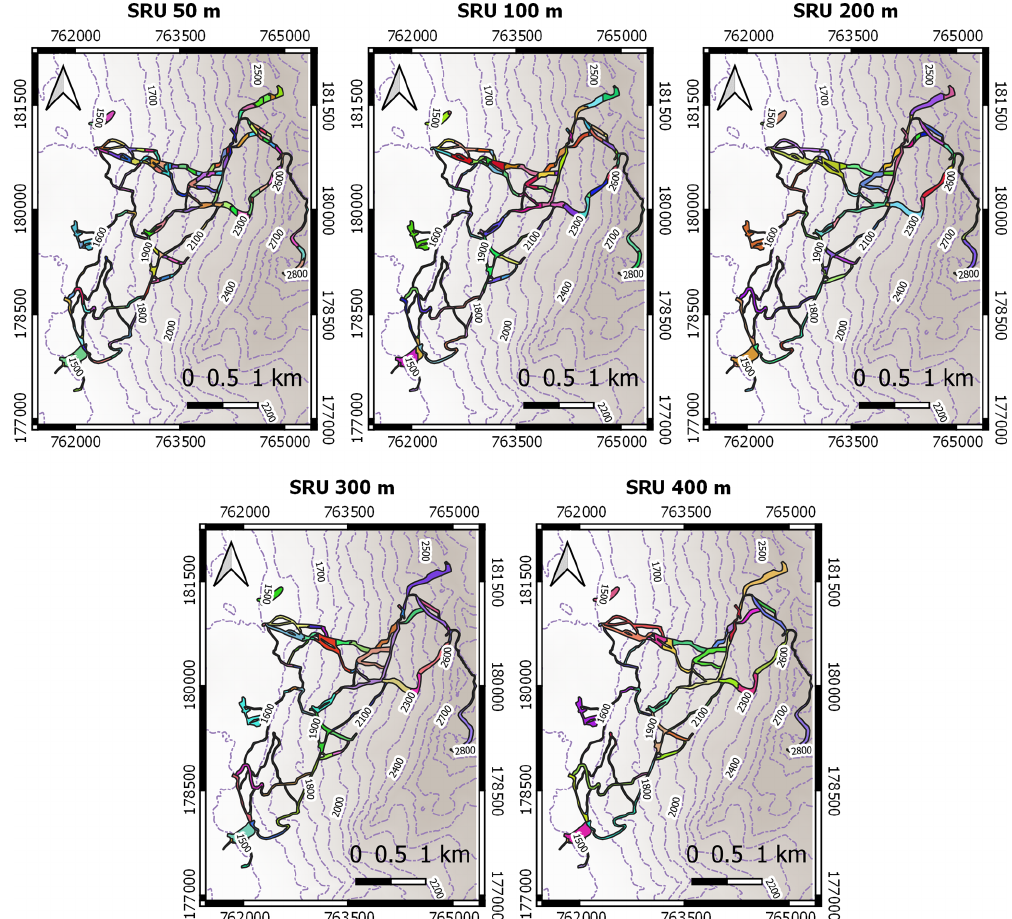
Figure 2. An example of a ski resort discretization into different SRU elevation bands: 50, 100, 200, 300, and 400m. The figure shows the western part of Arosa Lenzerheide. The different colors represent the different SRU